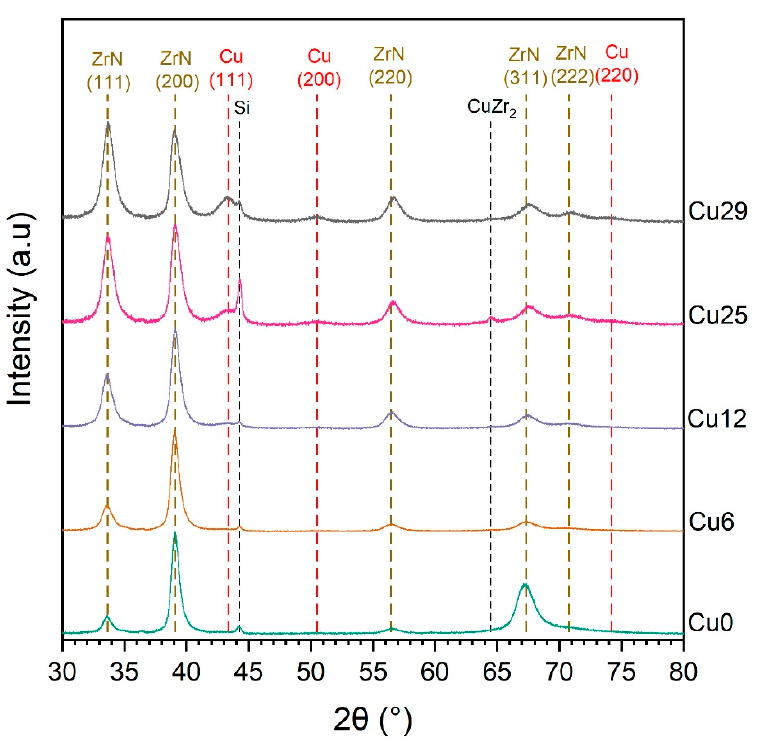
Figure 3. XRD patterns of ZrN-Cu coatings with different copper contents. Si diffractions originate from the substrate.